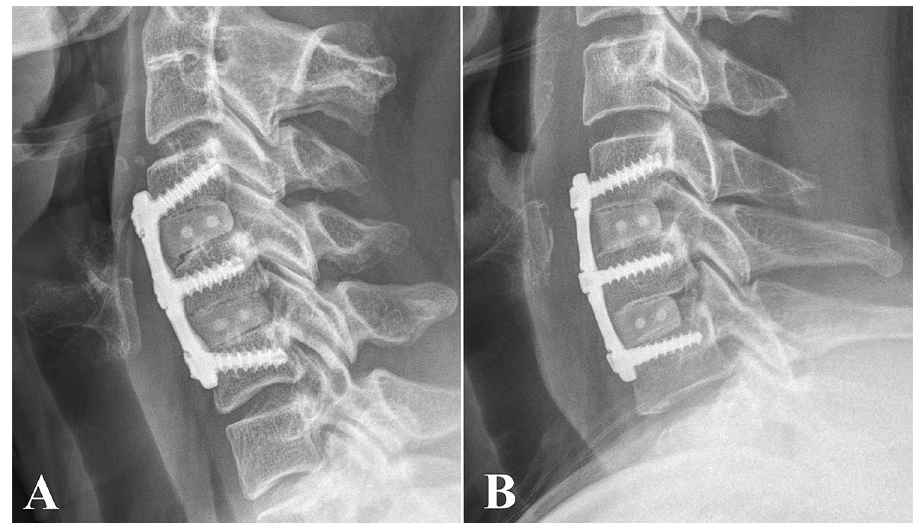
Figure 1. All variable screw construct and selective caudal fixed screw construct. ( A ) All variable screw construct. A short plate was selected to maintain the plate-adjacent disc space distance at > 5 mm. The screw was directed obliquely to insert the longest screw possible. ( B ) Selective caudal fixed screw construct. Fixed screws were inserted at the caudal level to increase stability. Variable screws were inserted at the cranial level and middle level. Fixed screw insertion at the caudal level allowed less caudal